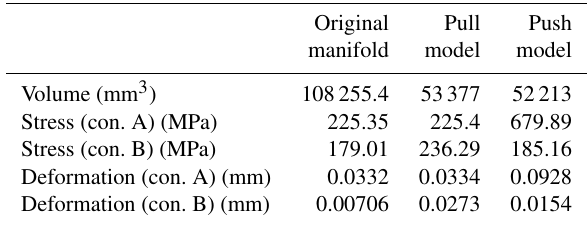
Table 4. Results of the pull and push models.